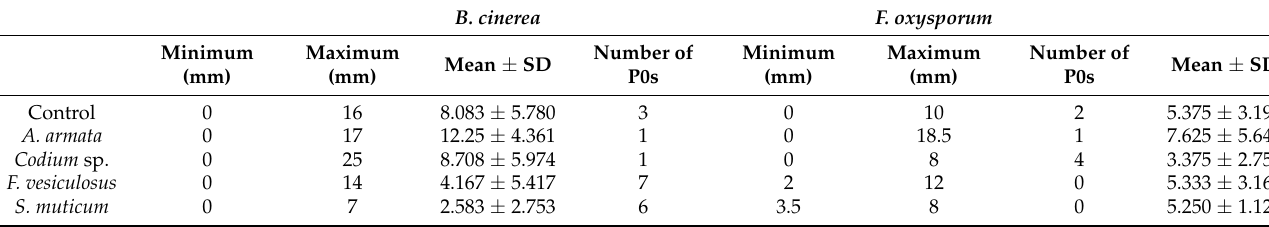
Table 4. Minimum and maximum radii of the halo decay, measured in millimeters (mm), at the end of the incubation of 11 days (264 h) for Botrytis cinerea and 7 days (168 h) for Fusarium oxysporum ), after immersion of the Rocha pears in the aqueous extracts of Asparagopsis armata , Codium sp., Fucus vesiculosus , and Sargassum muticum at 1 mg/mL and inoculation of the fruits with Botrytis cinerea or Fusarium oxysporum . The quantity of pears that did not show any decay halo (P0) is also indicated. The data of the growth control are also